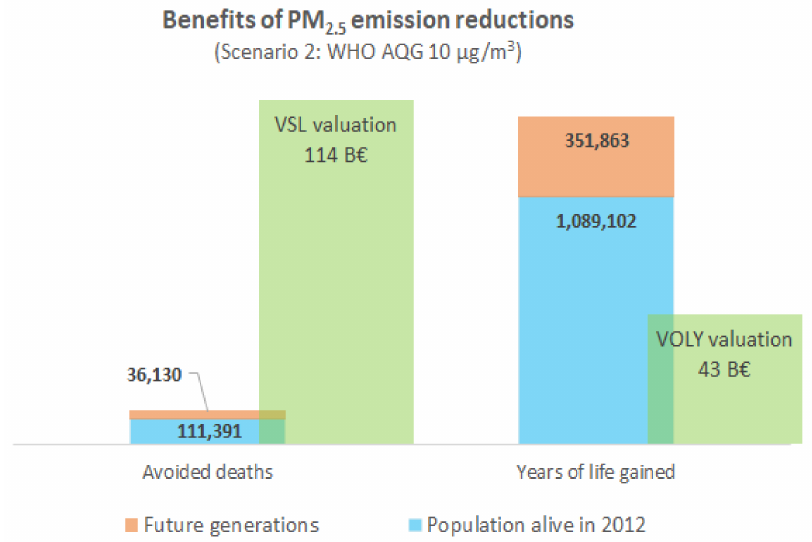
Figure 3. Scenario 2: Cumulative mortality benefit of PM 2.5 emission reductions for the city of Skopje aggregated over a follow up period of 105